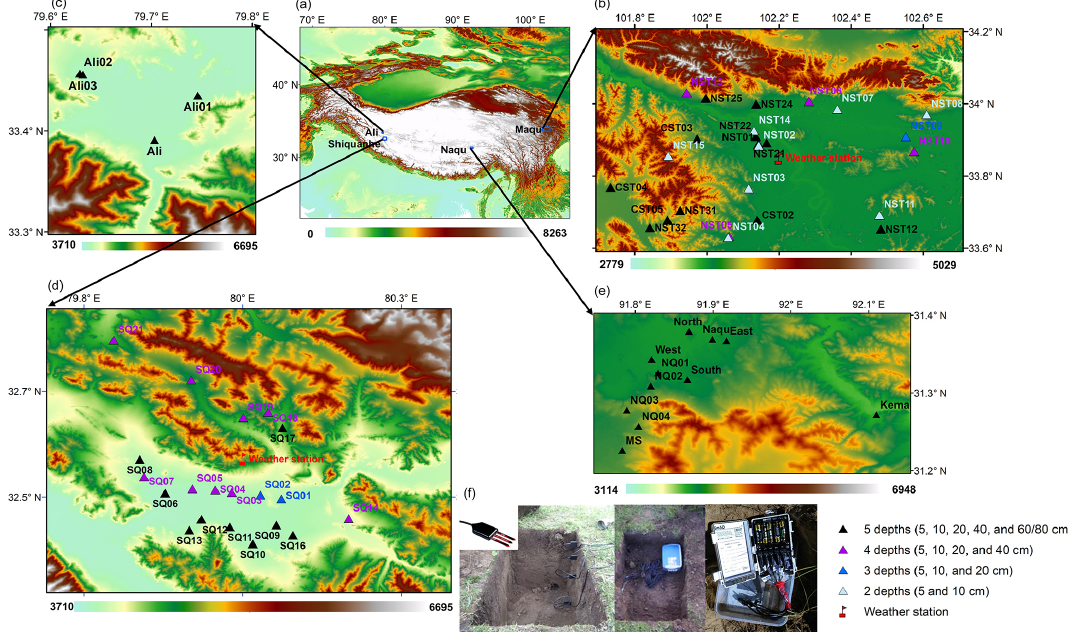
Figure 1. (a) Location of the Tibet-Obs network over the TP. Spatial distributions of SMST monitoring sites and weather station within the (b) Maqu, (c) Ali, (d) Shiquanhe, and (e) Naqu networks. (f) An example of the instruments configured for each SMST monitoring site. The elevation of the network is shown at the bottom of each subplot. The triangles with different colours represent the SMST measured at different depths. The base map is from the © U.S. Geological Survey’s Center for Earth Resources Observation and Science